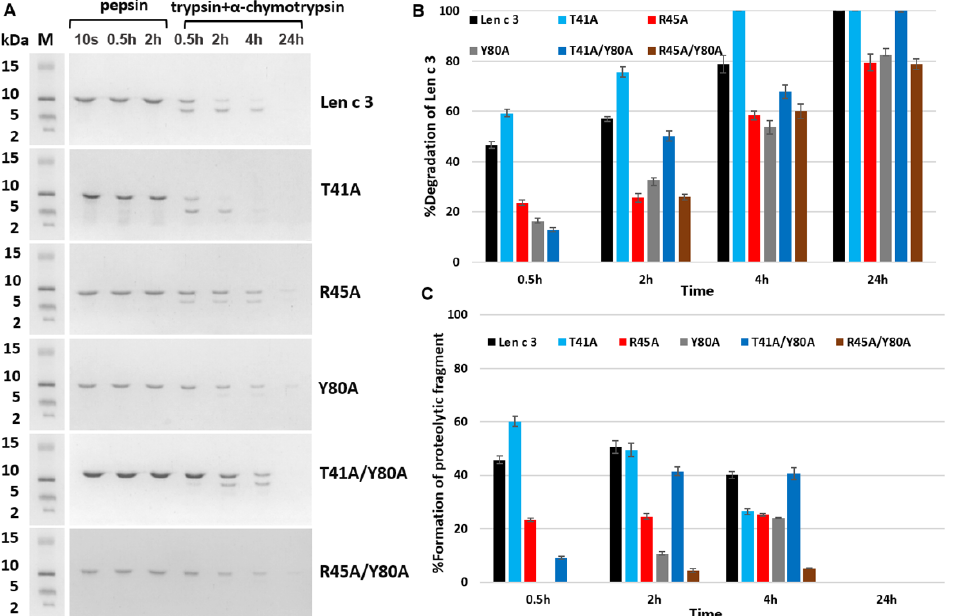
Figure 4. SDS-PAGE analysis of proteolytic fragments of Len c 3 and its mutant analogues after cleavage mimicking gastroduodenal digestion in vitro ( A ). M—molecular mass standards; 10 s, 0.5 h, 2 h—the proteins fragmentation by pepsin under conditions mimicking gastric digestion; 0.5 h, 2 h, 4 h, 24 h—digests after the subsequent proteins incubation with the mixture of trypsin and α-chymotrypsin mimicking their cleavage in human gut. Comparative analysis of duodenal digestion of Len c 3 and its mutant analogues ( B , C ). The bands corresponding to intact proteins ( B ) and their proteolytic fragments with molecular mass of 6–8 kDa ( C ) were registered using Gel Doc XR + imaging system (Bio-Rad) and Image Lab Software. Percentage of degraded proteins was calculated as (So − Sa)/So × 100%, where So is an area of the protein band at the initial time (10 s) and Sa is an area of the protein band at a specified time. Error bars represent standard deviation between technical replications. Differences in percentages of Len c 3 and its mutant analogues degradation were compared by t -test (significance level is p < 0.05 for all variants). Percentage of proteolytic fragments was calculated as Sp/So × 100%, where Sp is an area of the proteolytic product band at a specified time. Analysis of gastric protein digestion is not given since Len c 3 and its mutant analogues are practically not cleaved by pepsin.